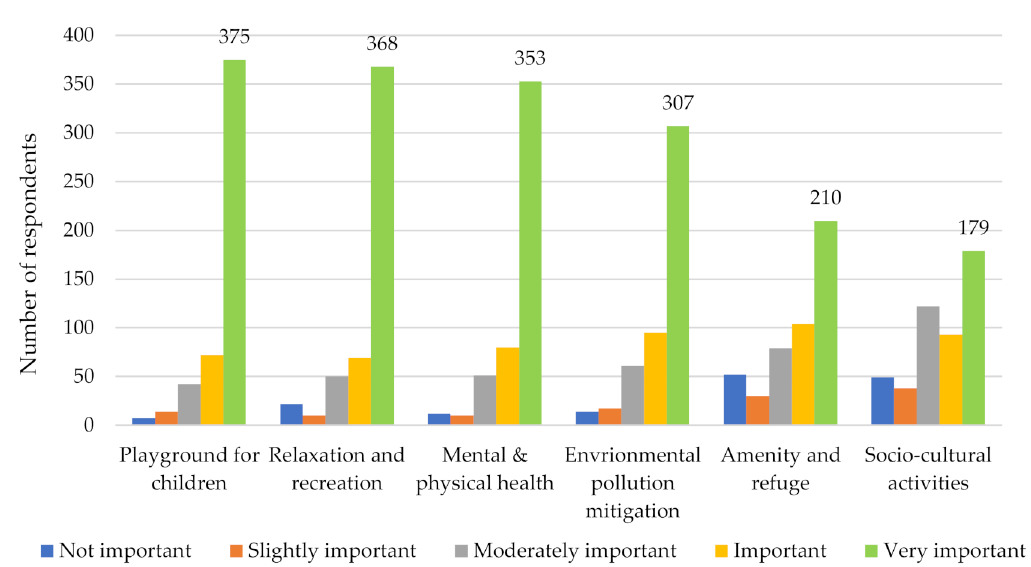
Figure 2. Respondent’s perception about urban park benefits (used all data including three types of housing).